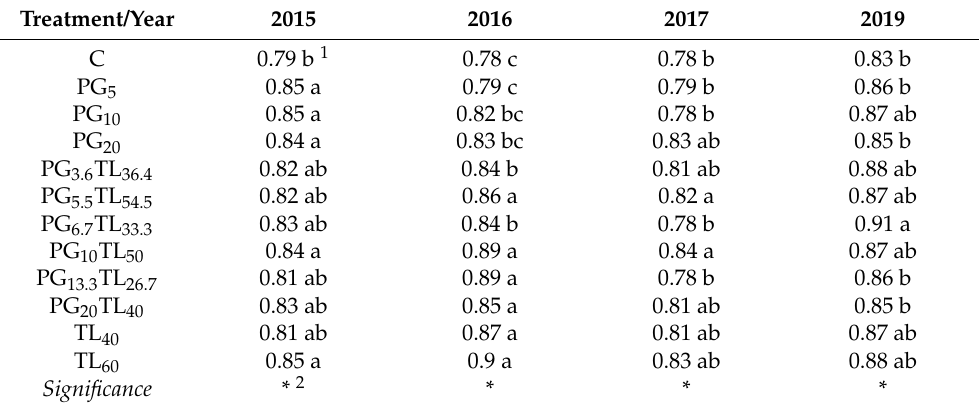
Table 5. Effect of treatments and years on the soil aggregate stability coefficients (K sas , 0–20 cm). Treatment/Year